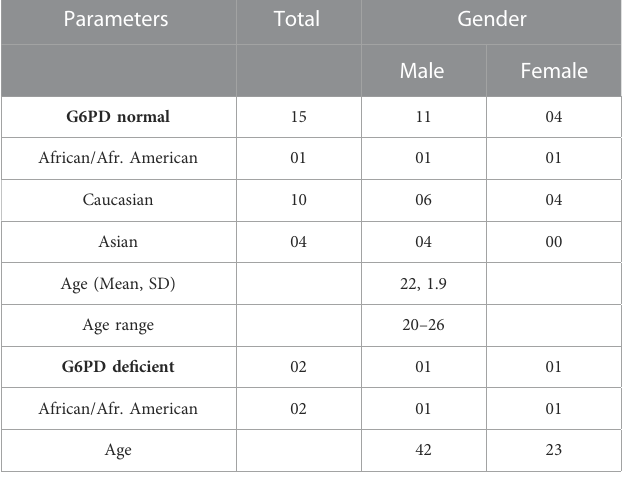
TABLE 1 Subject demographics and baseline clinical characteristics that participated in study.